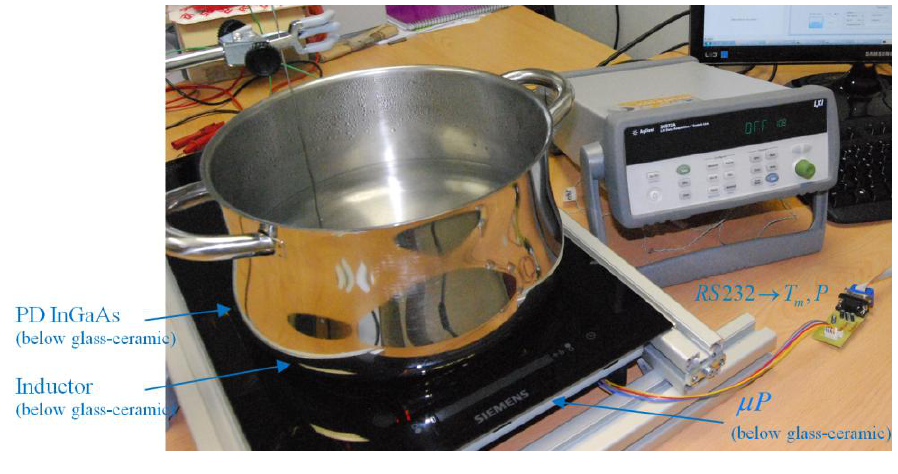
Figure 6. Experimental